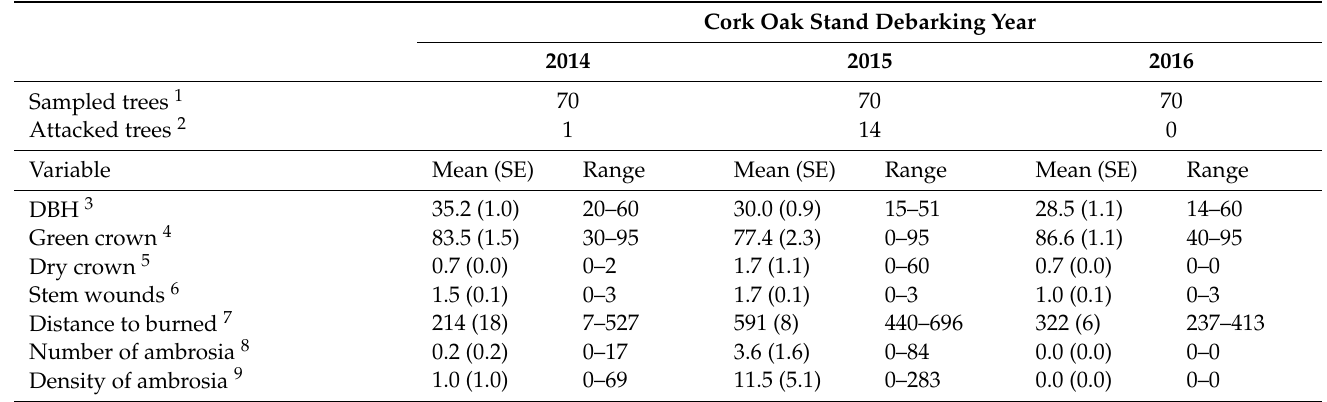
Table 5. Characteristics of the 210 unburned cork oak trees sampled in three private forest stands debarked in different years after the wildfire.